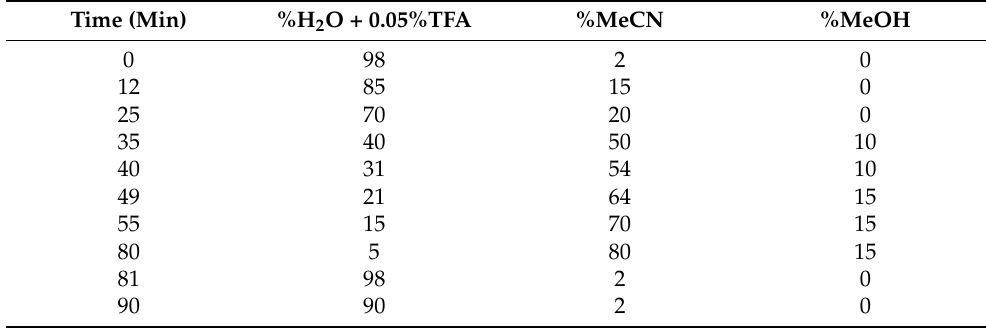
Table 6. LC-UV/DAD gradient program